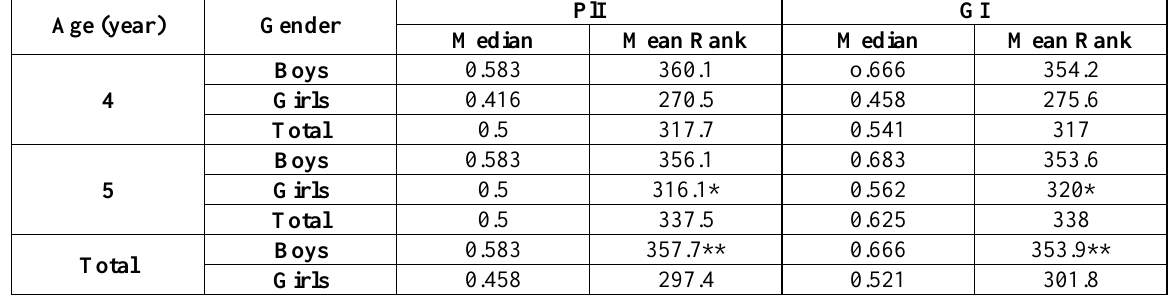
Table 4: plaque and gingival indices among children (Median and Mean rank) by age and